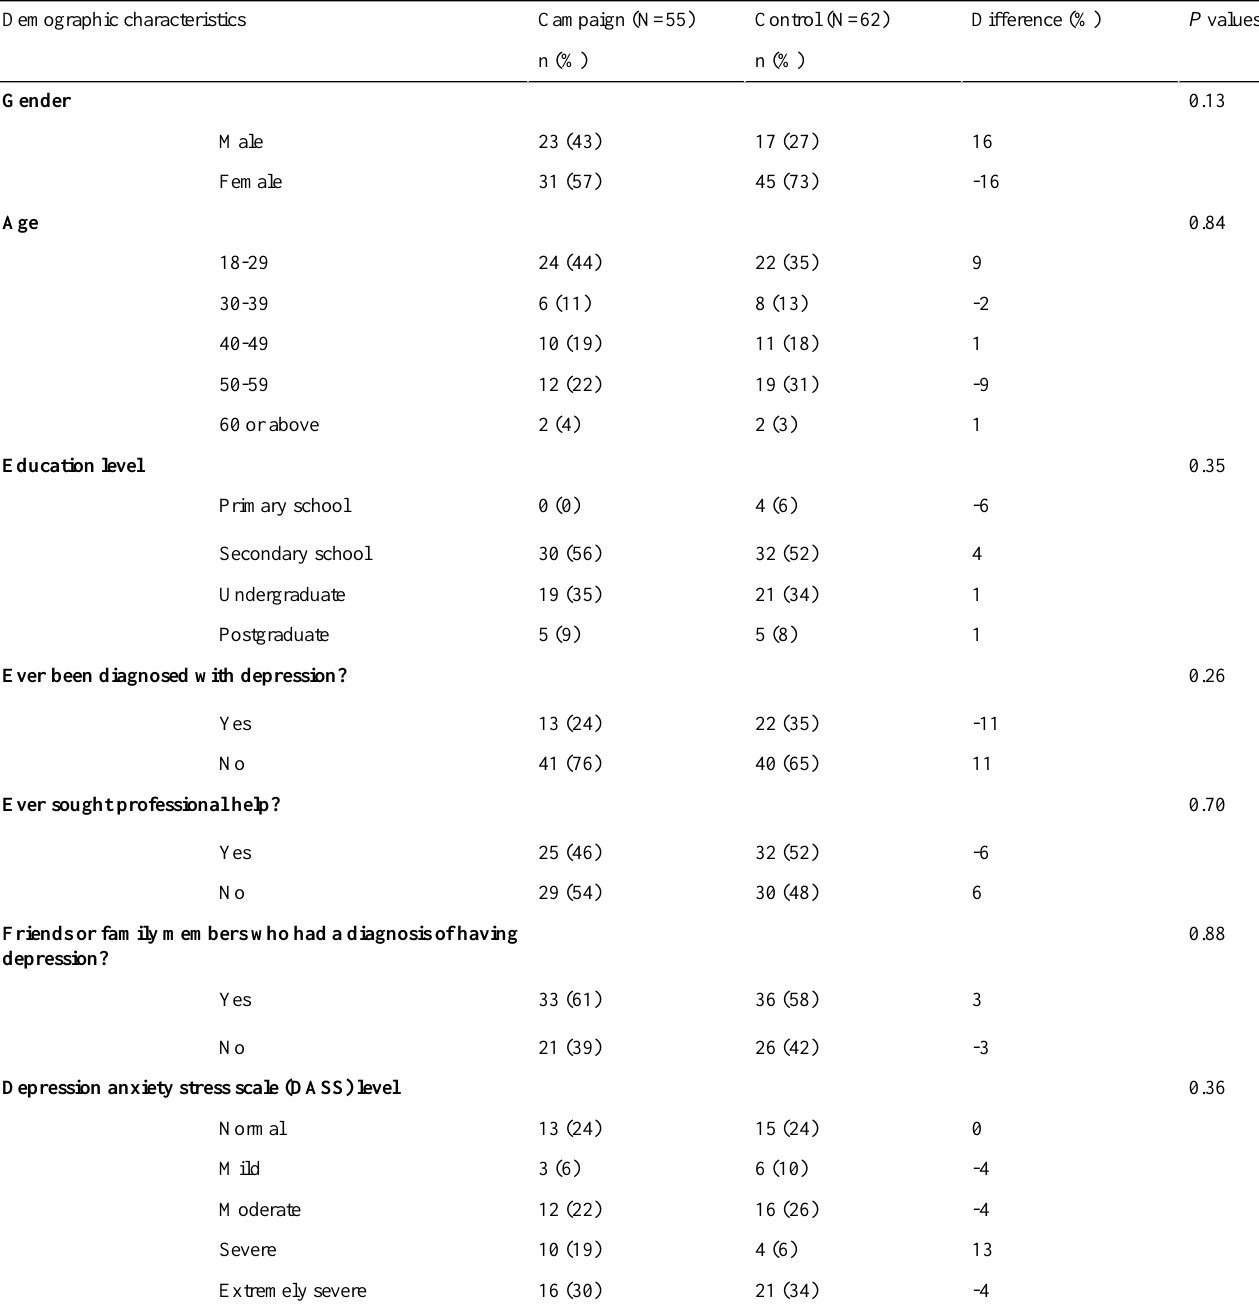
Table 1. Demographic characteristics of participants of the campaign and control